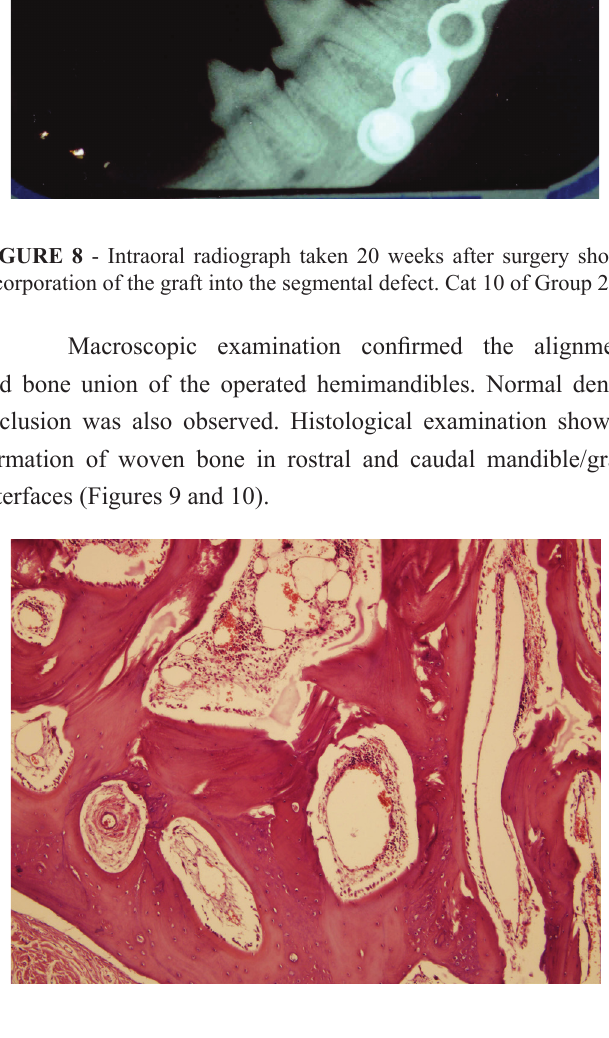
FIGURE 9 - Histologic section of the operated hemimandible shows that the mandible/graft interface was bridged by woven bone. Cat 22 of Group 2 specimen. (HE – 100X).